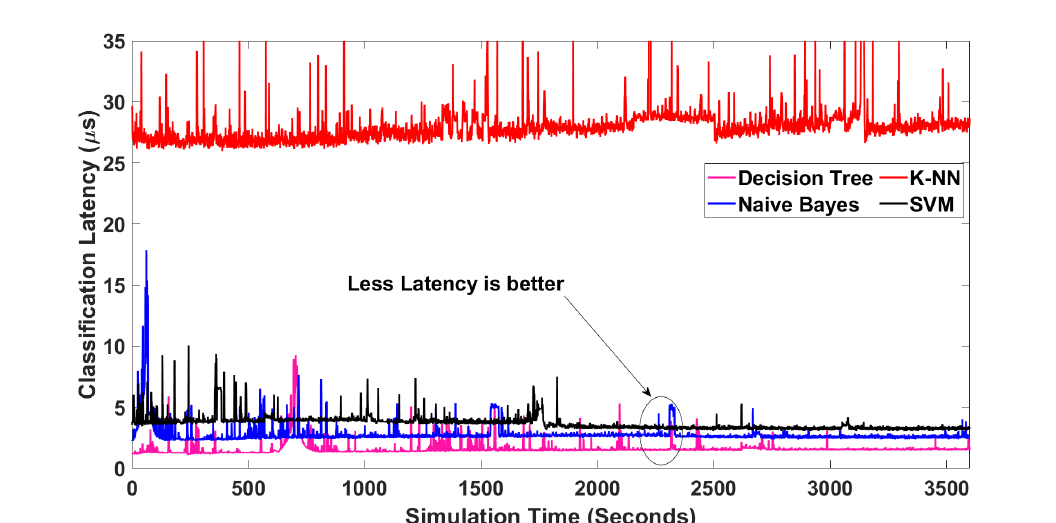
Figure 16. Comparison of NTCA classification latency.